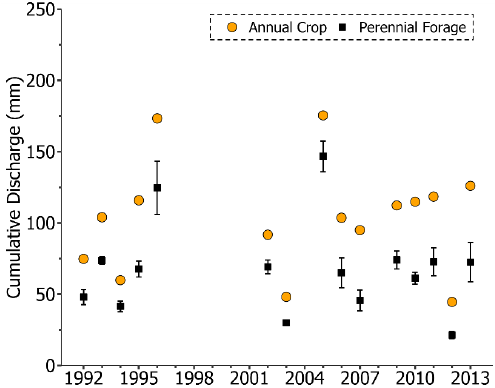
Figure 3. Comparison of the annual discharge volume between an- nual crop and forage simulations for the La Salle subbasin (LS- 05OG008). Error bars indicate the 95% confidence interval of the forage simulation ensemble. The years 1997–2001, 2004, and 2008 were not used for model assessment due to missing data or equip- ment